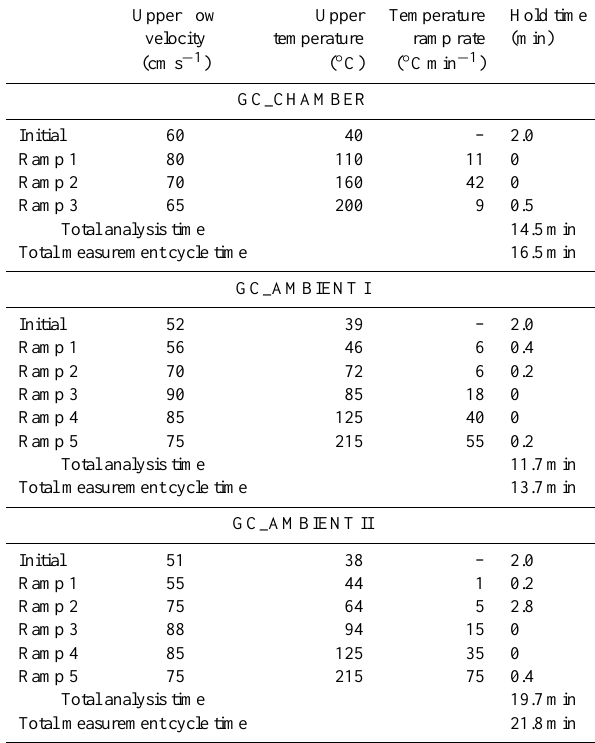
Table 2. Carrier gas flow velocities and temperature programmes utilised during Fast-GC analysis of BVOC in ambient air and single plant emissions. Upper